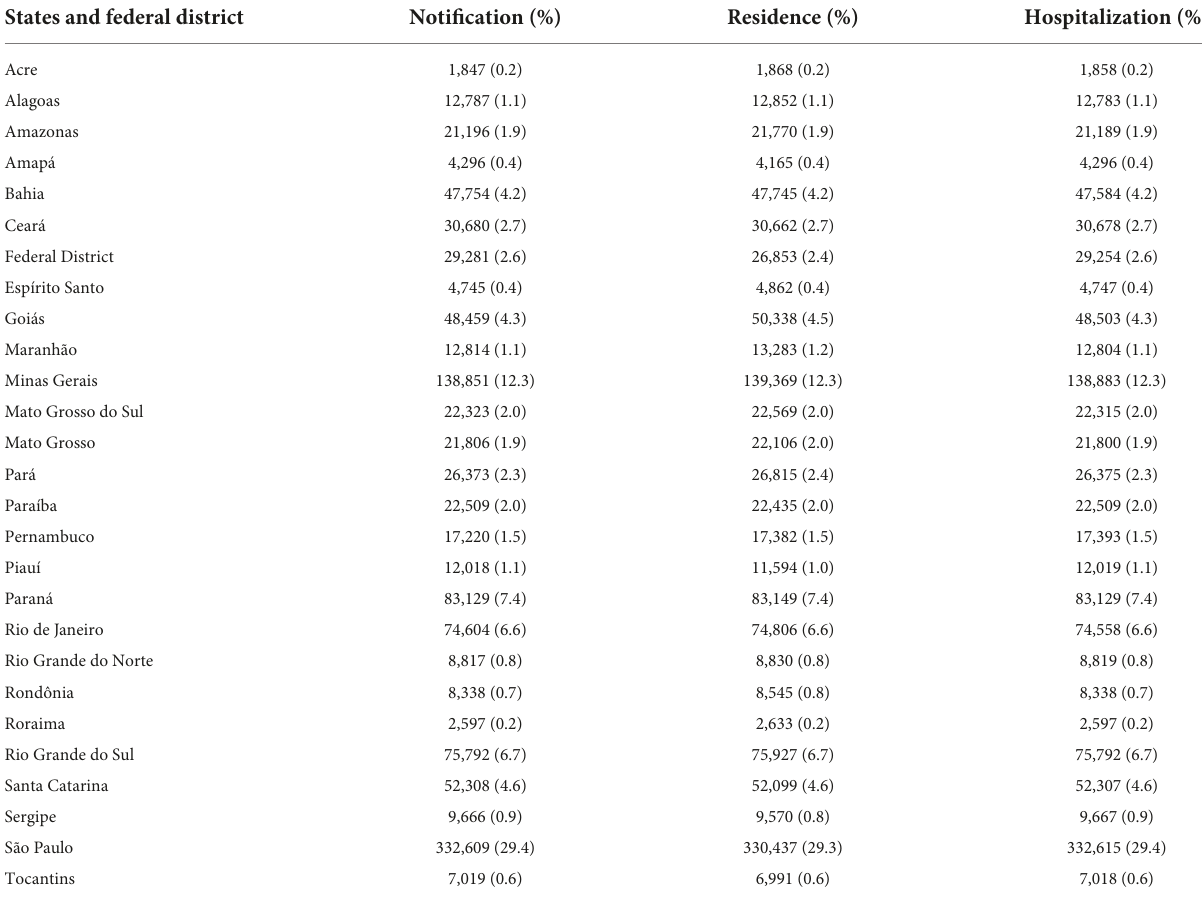
TABLE 1 Brazil’s region of notification, residence, and hospitalization of hospitalized patients due to severe acute respiratory syndrome (SARS) by the coronavirus disease (COVID-19) and the description of the asthma phenotype. States and federal